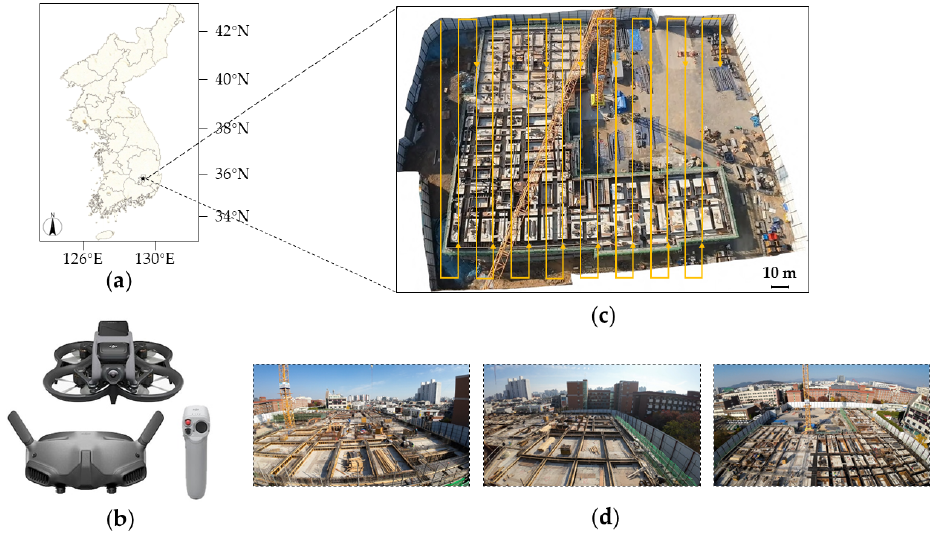
Figure 2. Experimental sites and data collection. ( a ) location of the test site, ( b ) UAV, wearable glasses, and operating stick, ( c ) an example of the UAV inspection path. ( d ) Example of UAV data.